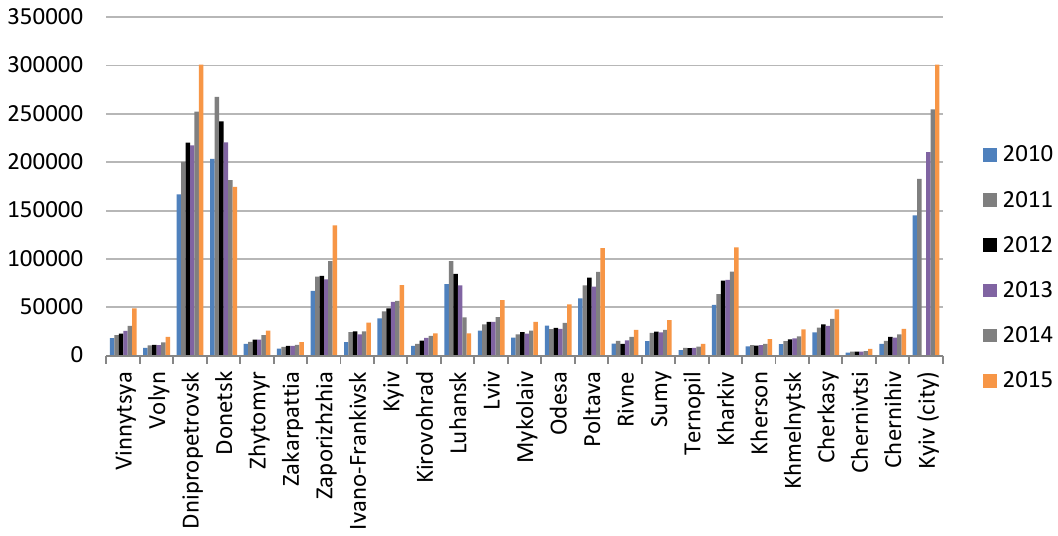
Fig. 4. The sales volume for industrial products (goods, services) by region in 2010 – 2015, million UAH (based on data of the